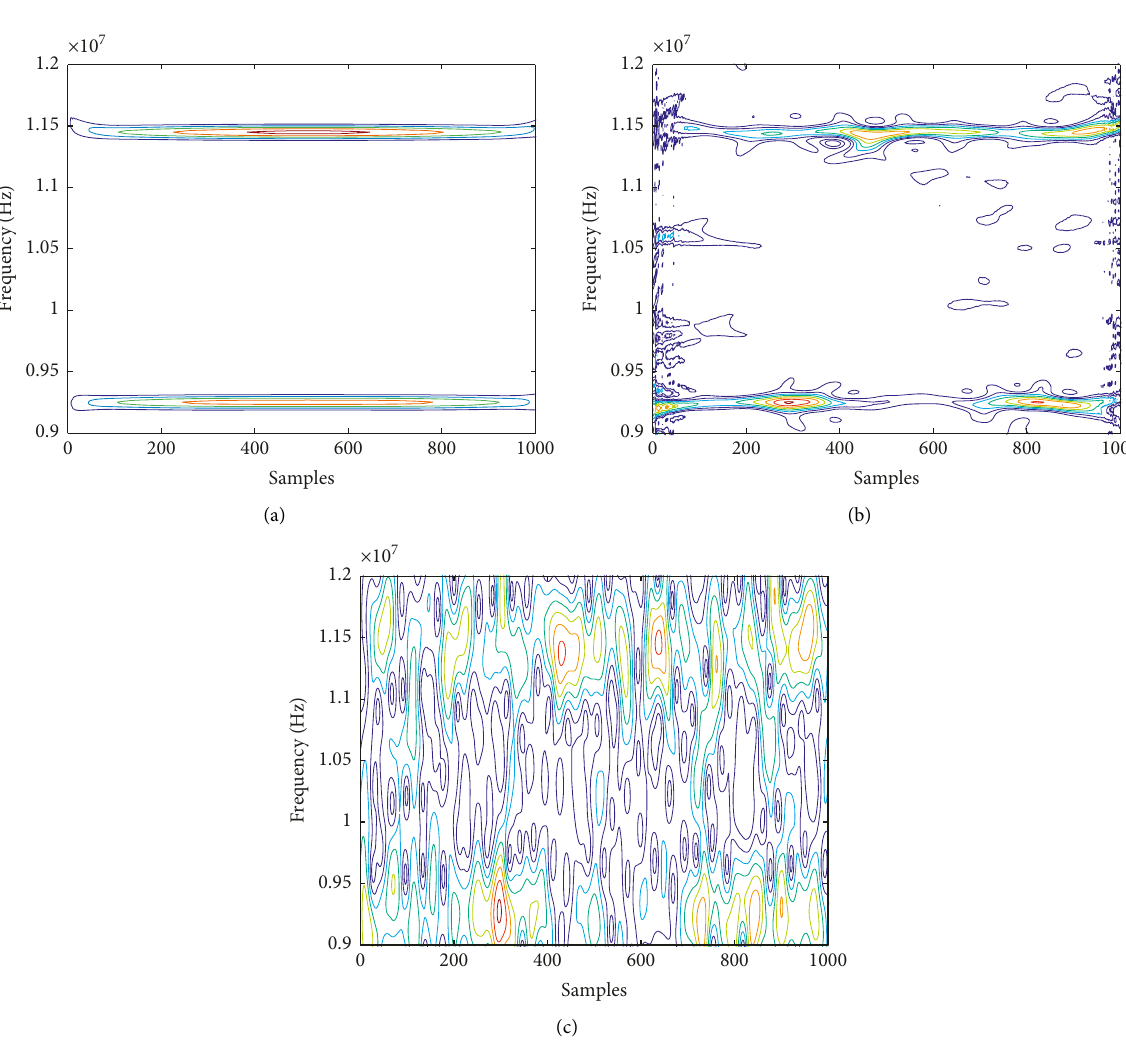
� 45dB-Hz, JNR � 18 dB. (a) Contour plot using FDPM 0